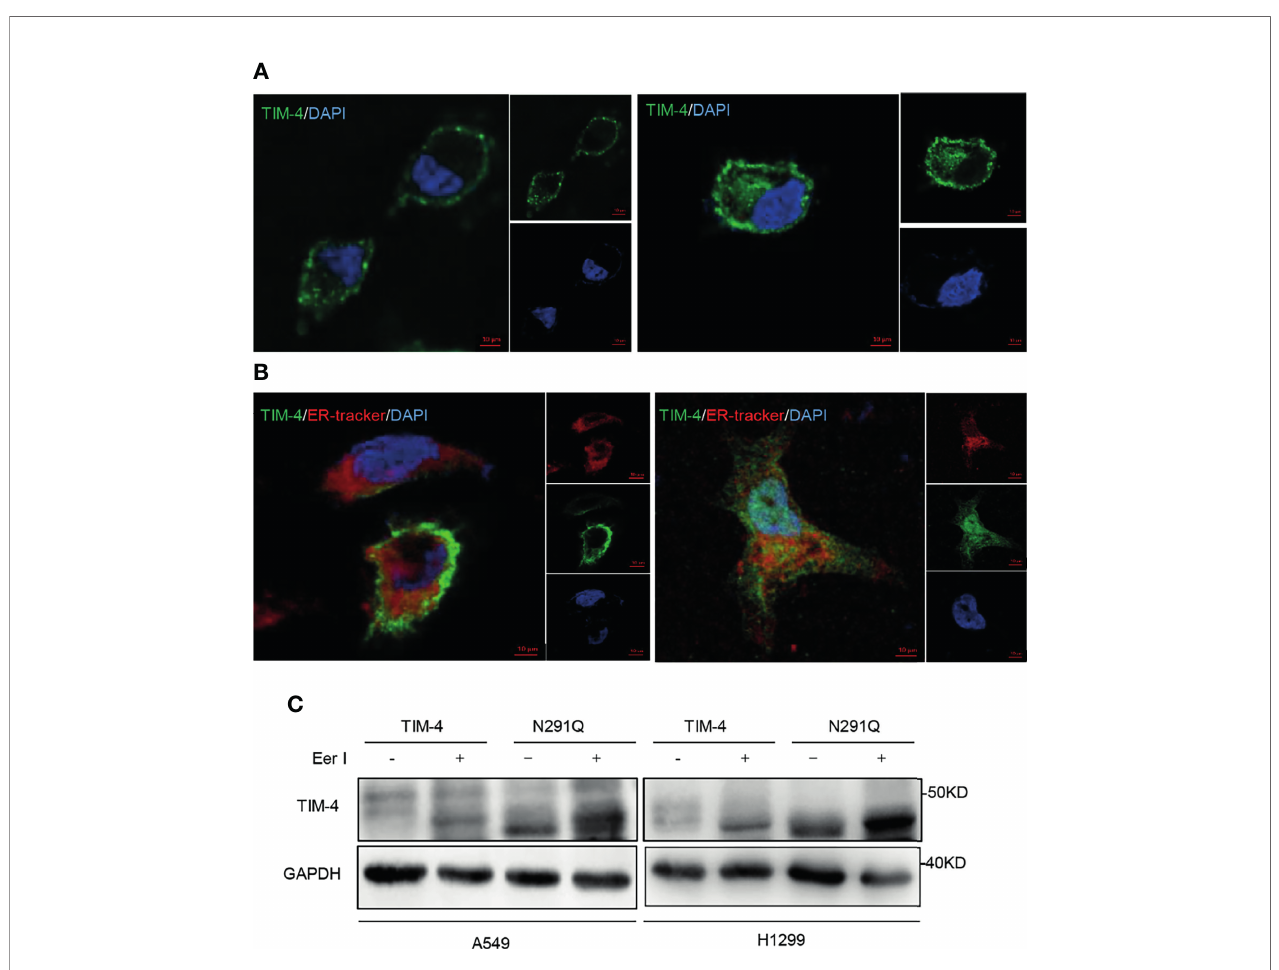
FIGURE 6 | Effects of N-glycosylation on location and degradation pathway of TIM-4. (A) Confocal immuno fl uorescence microscopy was used to detect location of TIM-4 in TIM-4-transfected and N291Q-transfected A549 cells. (B) Confocal immuno fl uorescence microscopy was used to detect colocalization between TIM-4 and ER in TIM-4-transfected and N291Q-transfected A549 cells. (Scale bar:10 m m). (C) Western Blot was used to detect the degradation pathway of